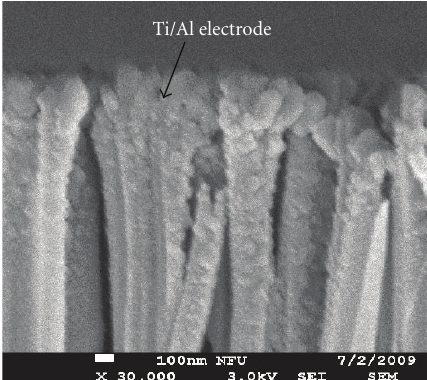
Figure 10: SEM image of Al/Ti/RJSNWp-Si(100) stacked structure with length of 10000 nm sample. Etching conditions were aqueous AgNO 3 /HF/H 2 O mixed chemical solution in a ratio of 4:34 :162 (volume) at 25 ◦ C for 30min.